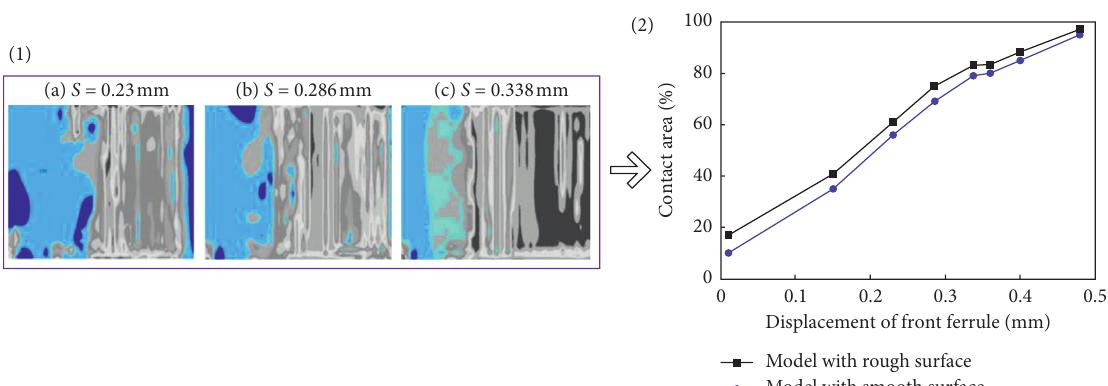
Figure 6: Quantitative analysis of sealing characteristics of pipeline